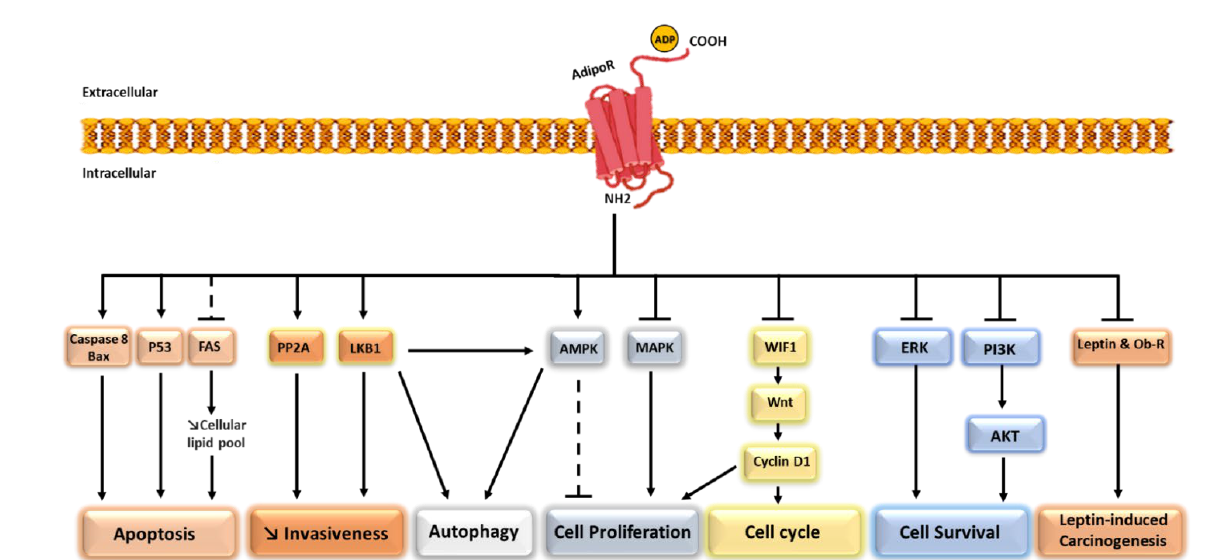
Figure 1. Potent anti-cancer activities of adiponectin by modulating a wide range of signaling pathways. Adiponectin binds to AdipoR1/2 and (1) inhibits cell proliferation by activating AMKP and inhibiting MAKP, (2) induces cell cycle arrest by indirect inhibition of Cyclin D1 through the Wnt pathway, (3) inhibits invasiveness by activating LKB1 and PP2A, (4) induces apoptosis by activating Bax, Caspase 8, and P53 and decreasing the cellular lipid pool through the inhibition of FAS, (5) induces autophagy through LKB1 and AMKP, (6) decreases cell survival through the inhibition of ERK and PI3K, and finally, (7) inhibits leptin-induced carcinogenesis by decreasing the expression of Leptin and the Leptin receptor. ADP: Adiponectin, Bax: Bcl-2–associated X, FAS: Fatty acid synthase, PP2A: Protein phosphatase 2A, LKB1: Liver kinase B1, AMPK: Adenosine monophosphate-activated protein kinase, MAPK: Mitogen-activated protein kinase, WIF1: Wnt inhibitory factor-1, Wnt: Wingless-related integration site, ERK: Extracellular signal-regulated kinase, PI3K: Phosphatidylinositol 3-kinase, Akt: Protein kinase B, Ob-R: Leptin